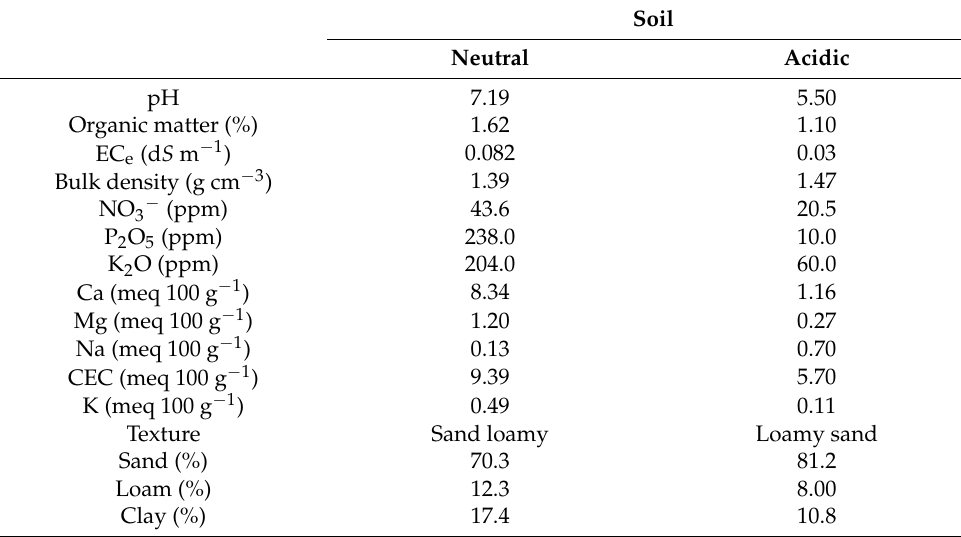
Table 1. The physicochemical properties of the soils.